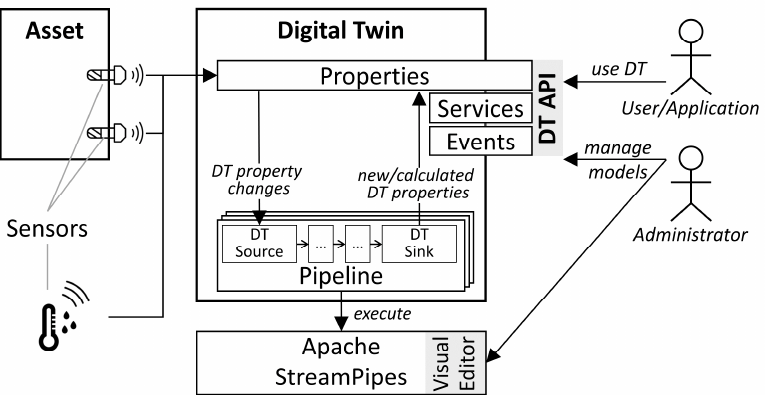
Figure 4. Adaptation of the general hybrid digital twin architecture to our implementation.